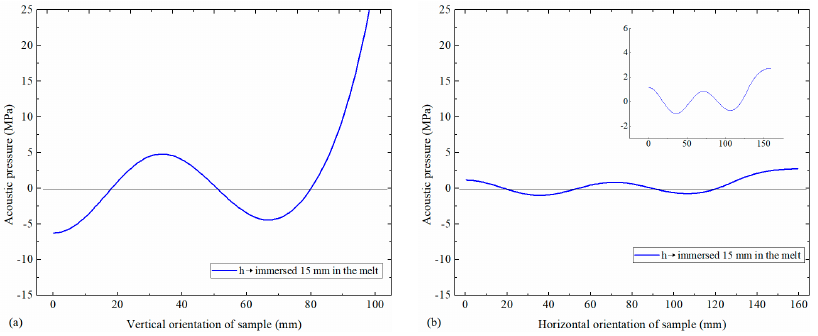
Figure 8. Numerical results of the acoustic pressure obtained in the ( a ) vertical and ( b ) horizontal directions.